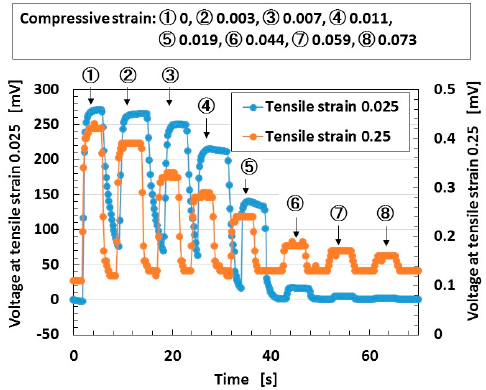
Figure 9. Change in voltage by repetition of compression under elongation under ultraviolet light for a wet-type MCF rubber solar cell electrolytically polymerized under a magnetic field with 0.22 g of Ruthenium complexes dye and 7.4 g of KI+I 2 electrolyte. The MCF rubber had 3 g of TiO 2 , 6 g of Ni, 4.5 g of MF, and 9 g of NR-latex. The irradiation light was ultraviolet (40 lx). The experimental apparatus and procedure were the same as those used in the second report [19]. 1 (cid:13) to 8 (cid:13) indicate each degree of compressive